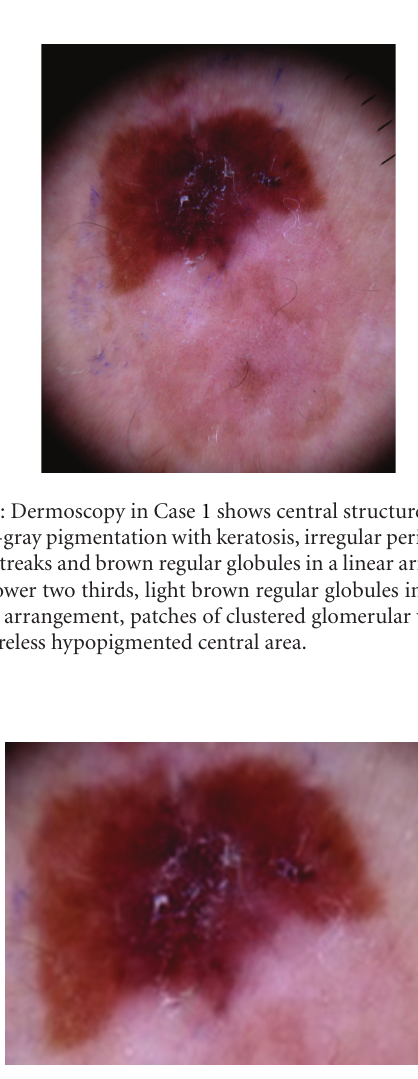
Figure 6: Case 1. Closeup view of upper third of the lesion with peripheral streaks, central brown and blue-gray pigmentation with keratosis and brown globules in a linear arrangement.